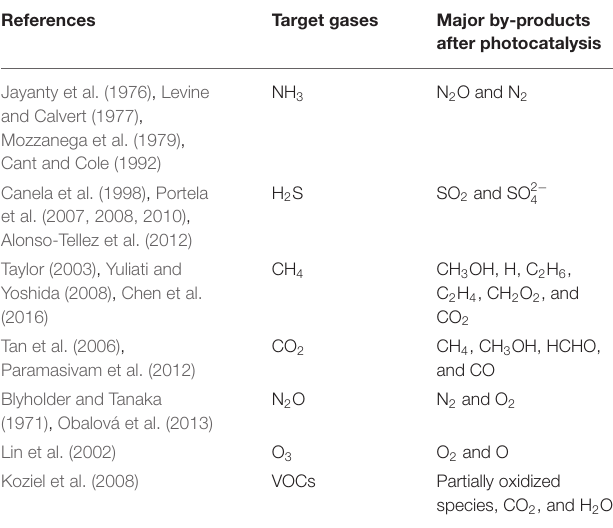
TABLE 13 | List of major by-products after